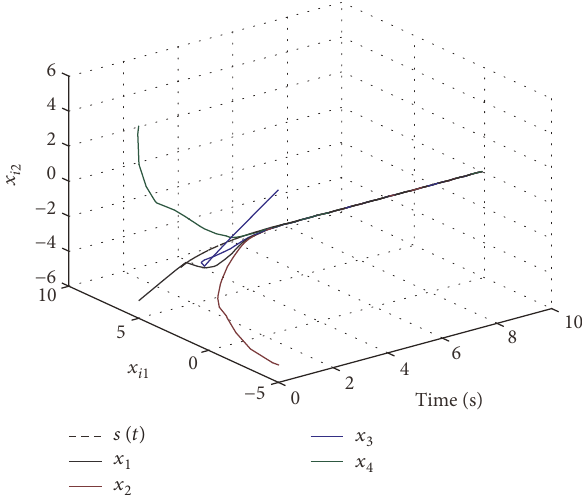
Figure 2: The state responses of the resulting closed-loop CDNs.